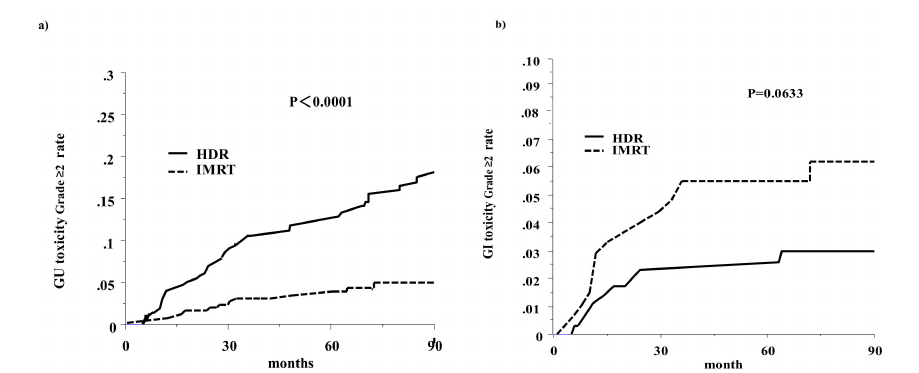
Figure 2. The accumulated incidence of grade ≥ 2 toxicity: ( a ) Genitourinary toxicity; ( b ) Gastrointestinal